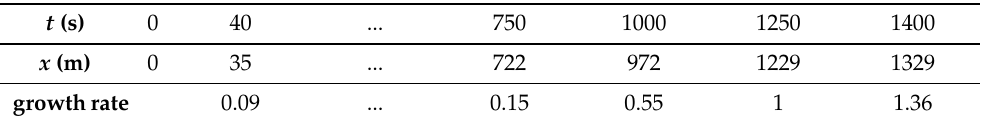
Figure 1. The non dimensional SGN soliton solution on a water surface at finite depth h = 0.14 m, with a wind speed of 10 m U 10 = 4.82 m/s, is plotted on an unscaled x -axis at times t = 750 s, t = 1000 s, t = 1250 s and t = 1400 s. Table 1. The growth rate of the SNG solitary wave at different times and positions, for depth h = 0.14 m, and wind speed of 10 m U 10 = 4.82